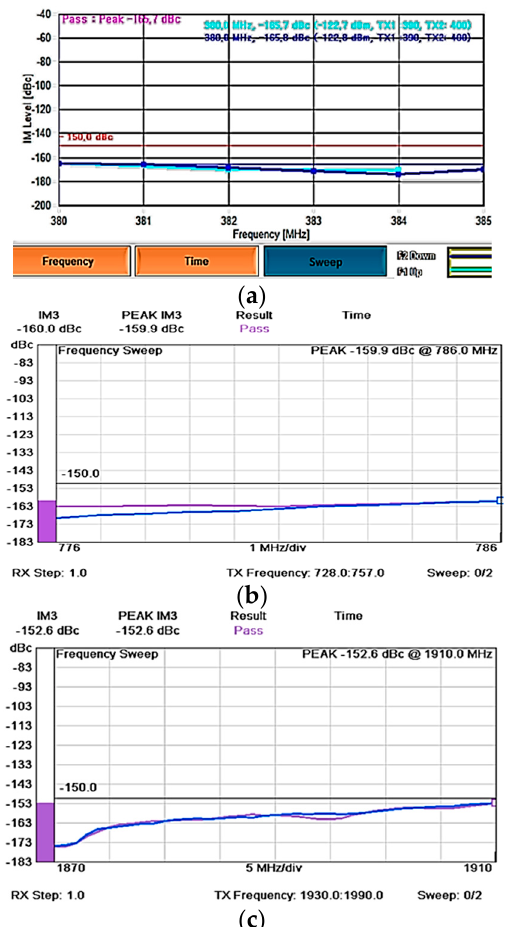
Figure 29. The measured PIM level for (a) 380 MHz-band (b) 700 MHz-band and (c) 1920 MHz- band.